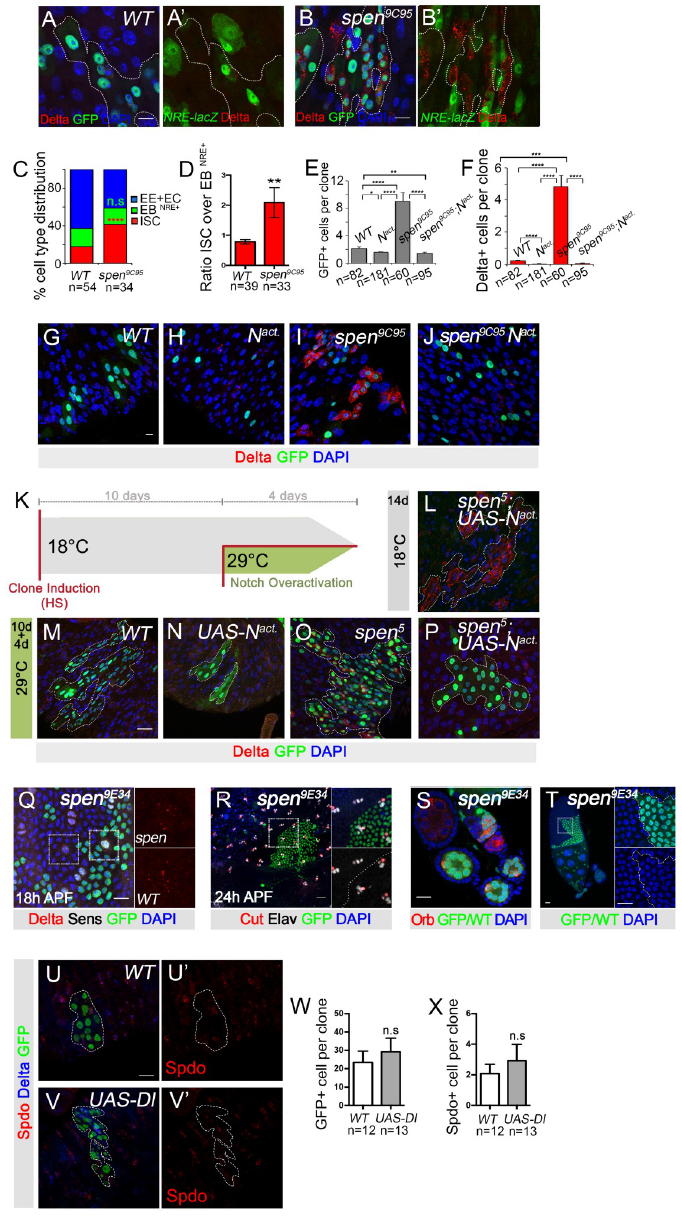
Fig 3. spen controls an early stem cell commitment event. (A, A’) Wild-type and (B, B’) spen 9C95 5 day AHS MARCM clones showed activation of the Notch pathway, as detected by NRE-lacZ (Notch Responsive Element, also called Su(H)-GBE-LacZ ) [57], ßGal, Green) (GFP, GREEN; DAPI, BLUE). (C) Quantification of cell type distribution, ISCs (Dl+ cells) in RED; EBs (EC precursors, NRE-LacZ+, in GREEN), and combined other cells representing mostly EEs and ECs, in BLUE. While the production of EB (NRE+) cells per clone was not affected upon spen inactivation, the proportion of Dl+ ISC-like cells significantly increased spen 9C95 clones. (D) Upon spen inactivation, ISC-like cells were more produced compare to EB (NRE+) cells. (E) Quantification of the number of GFP+ cells per clone or (F) Dl+ cells per clone for G-J (below). Single cell clones have been included in these quantifications (E-F). (G) Control wild-type clones produce multi-cell clones, whereas (H) the expression of an activated form of the Notch receptor ( UAS-N act ) promoted differentiation. (I) Similarly, spen mutant ISCs produced multi-cell clones whereas (J) the expression of UAS-N act drove differentiation and resulted in single-cell clones. (Dl+, RED; clones marked by GFP in GREEN; DAPI in BLUE (G-J). (K) Scheme of experimental set-up: Mitotic clones were first generated, then UAS-N Act was expressed after 10 days in these clones by releasing Gal80ts inhibition at 29˚C during 4 days. (L) spen 5 ; UAS-N Act genotype at 18˚C where Gal80ts was active therefore UAS-N Act was not induced. (M-P) At 29˚C, Gal80ts became inactive in (M) wild-type clones, (N) those expressing UAS-N Act , (O) spen 5 clones, and (P) spen 5 ; UAS-N Act . Delta+ in RED;